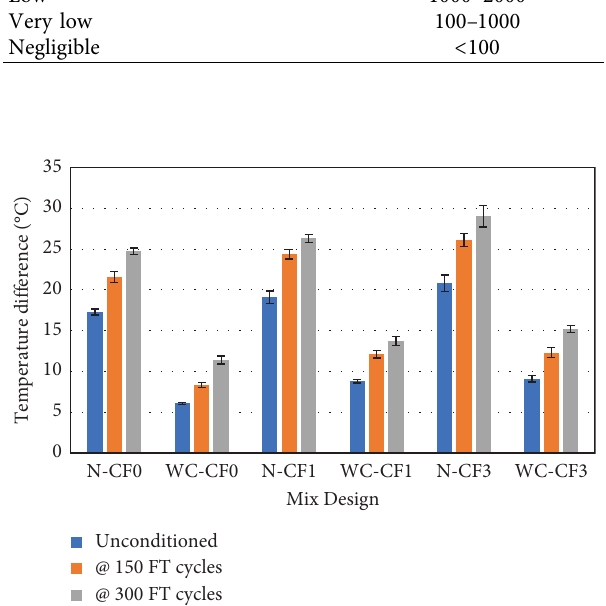
Figure 7: Results of temperature changes of